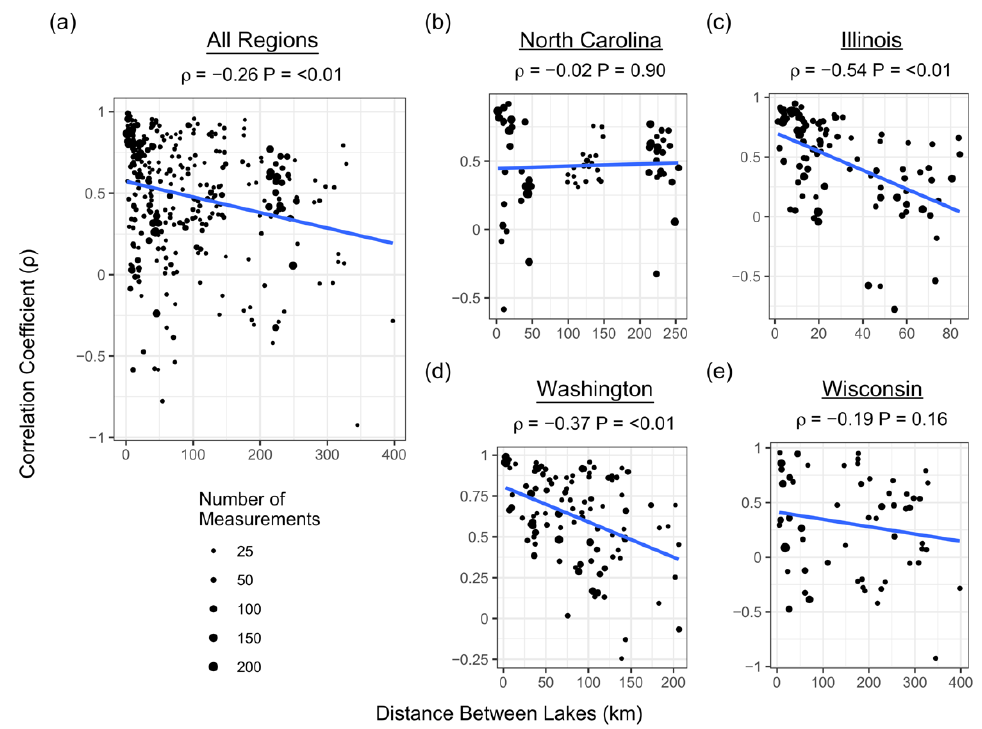
Figure 11. Relationship between the Spearman’s correlation coefficient ( ρ ) of change in lake water storage between paired lakes in a region and the distance between those two lakes: all regions ( a ), North Carolina ( b ), Illinois ( c ), Washington ( d ),